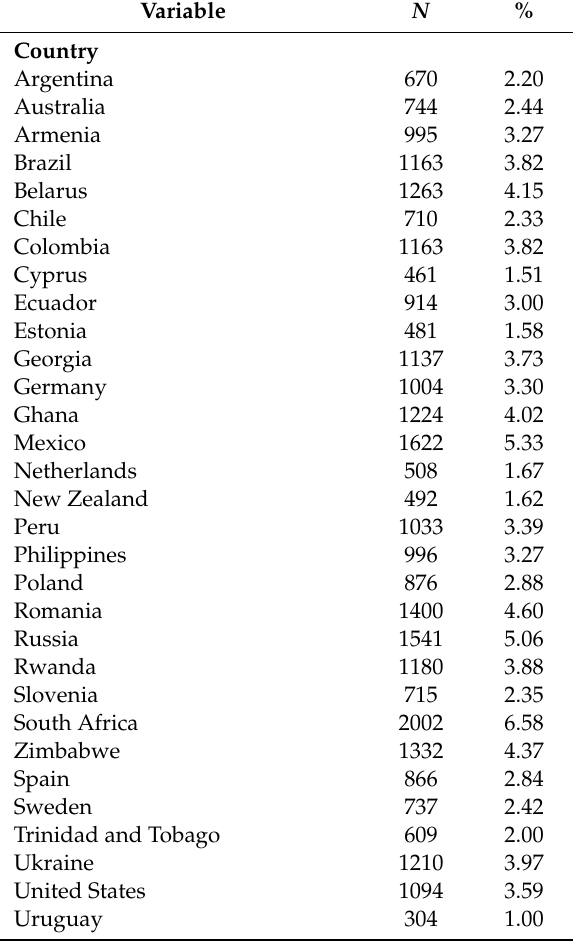
Table 1. Socio-demographic sample characterization ( N =